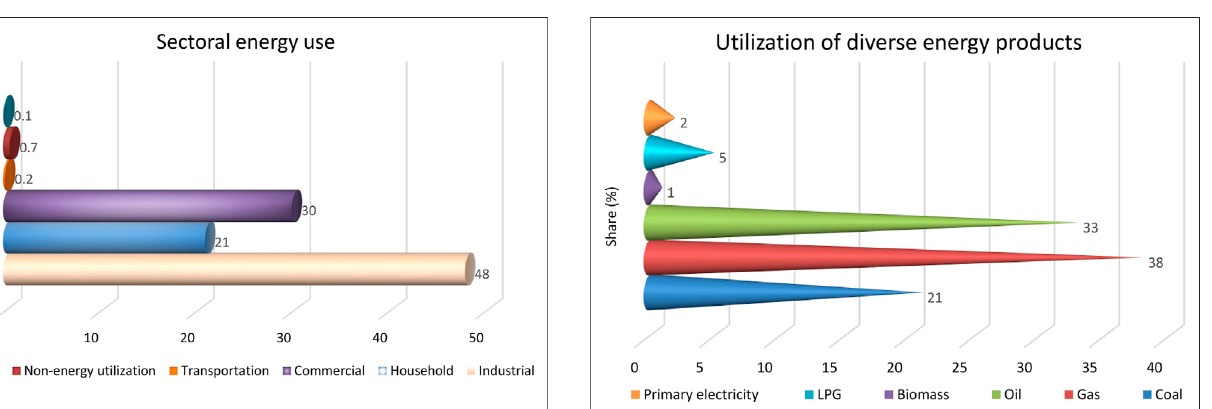
FIGURE 2 | Malaysia ’ s sectoral energy use in 2017.